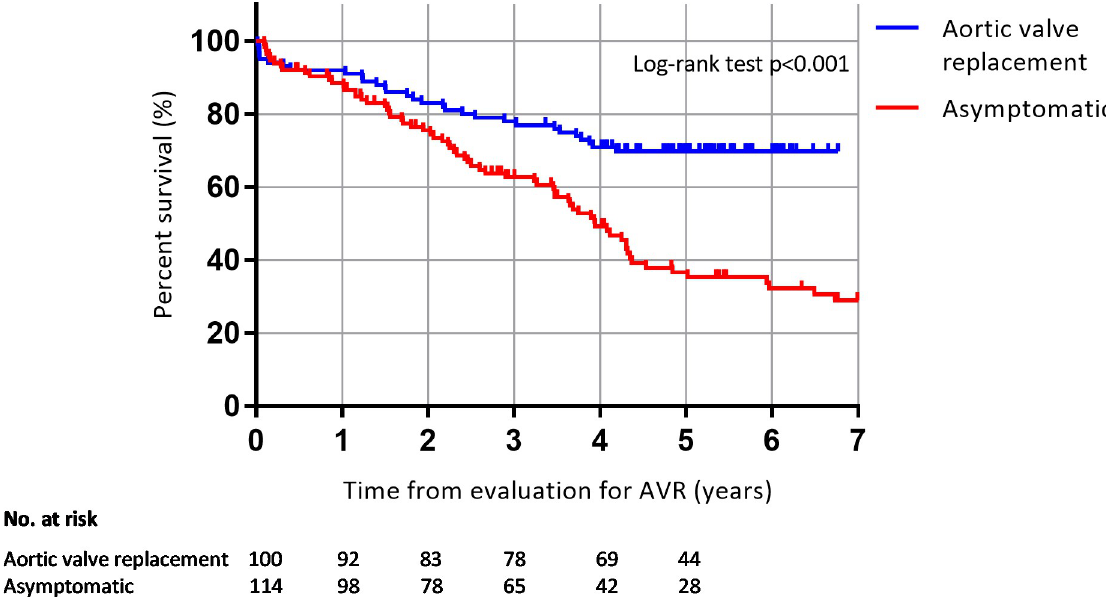
Fig 3. Survival analysis. Kaplan-Meier curve reflection survival in asymptomatic patients with severe aortic stenosis compared to 100 matched patients referred for aortic valve replacement.